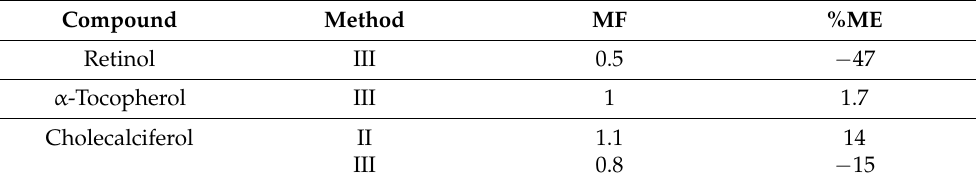
Table 9. Matrix factor and matrix effect for each analyte in LC-MS/MS